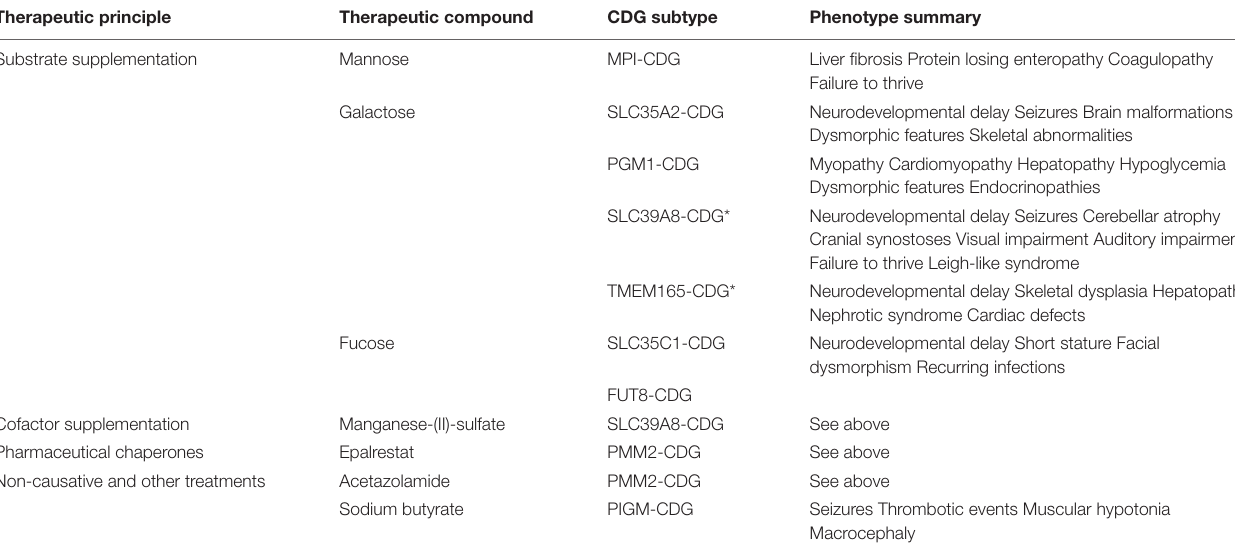
TABLE 1 | Overview and categorization of treatable congenital disorders of